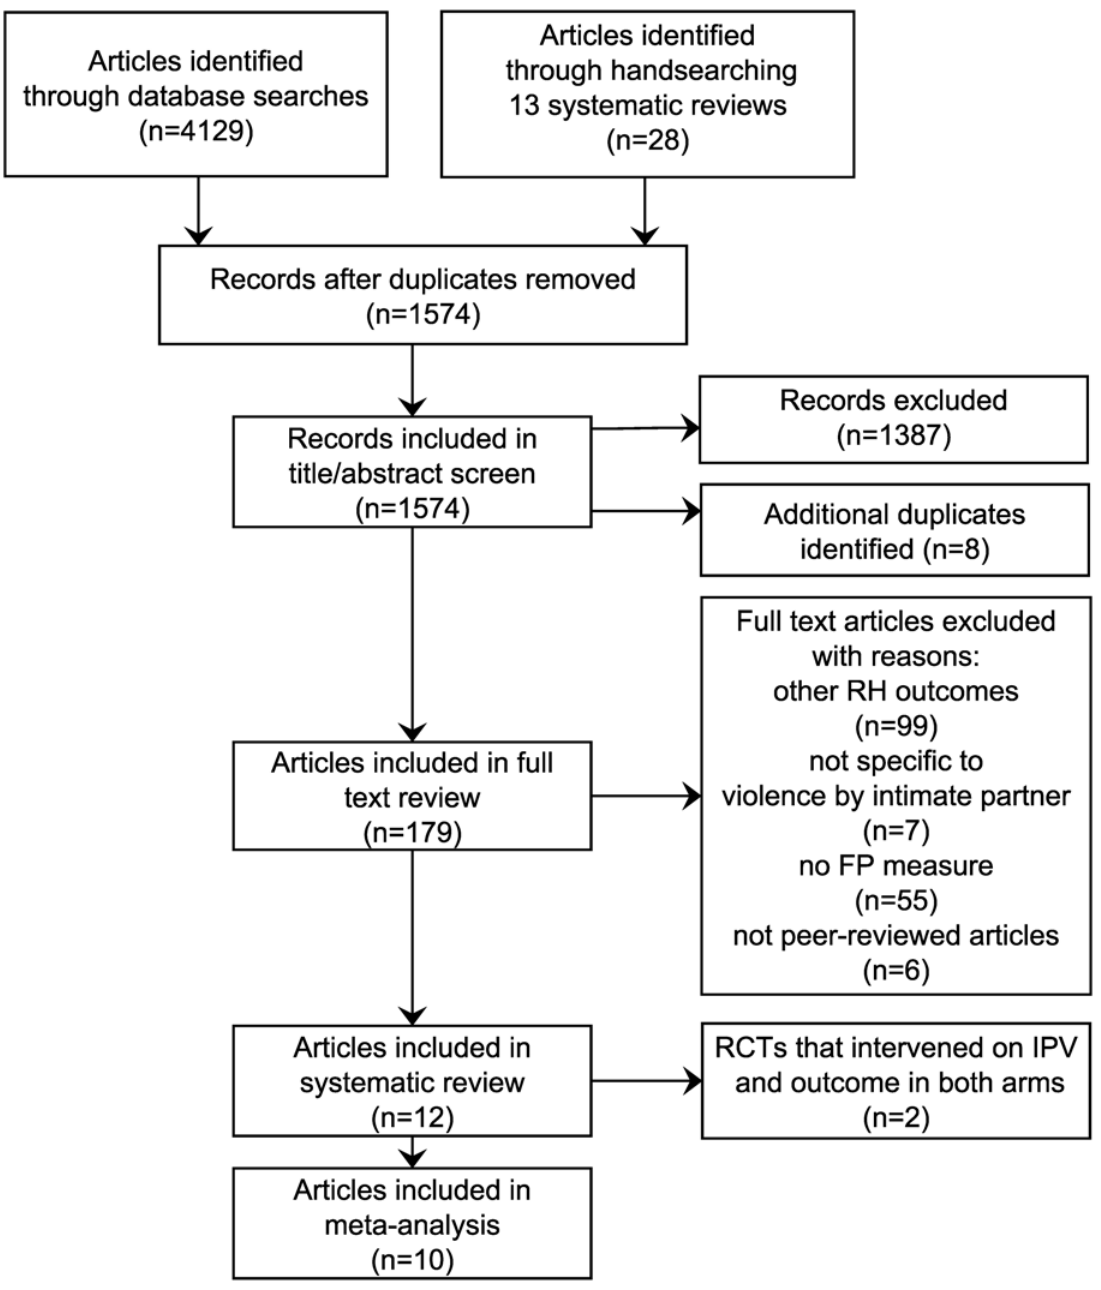
Fig 1. PRISMA flow